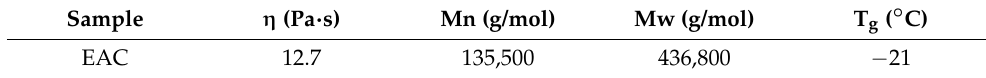
Table 2. Dynamic viscosity, molecular weight, and glass transition temperature values of the